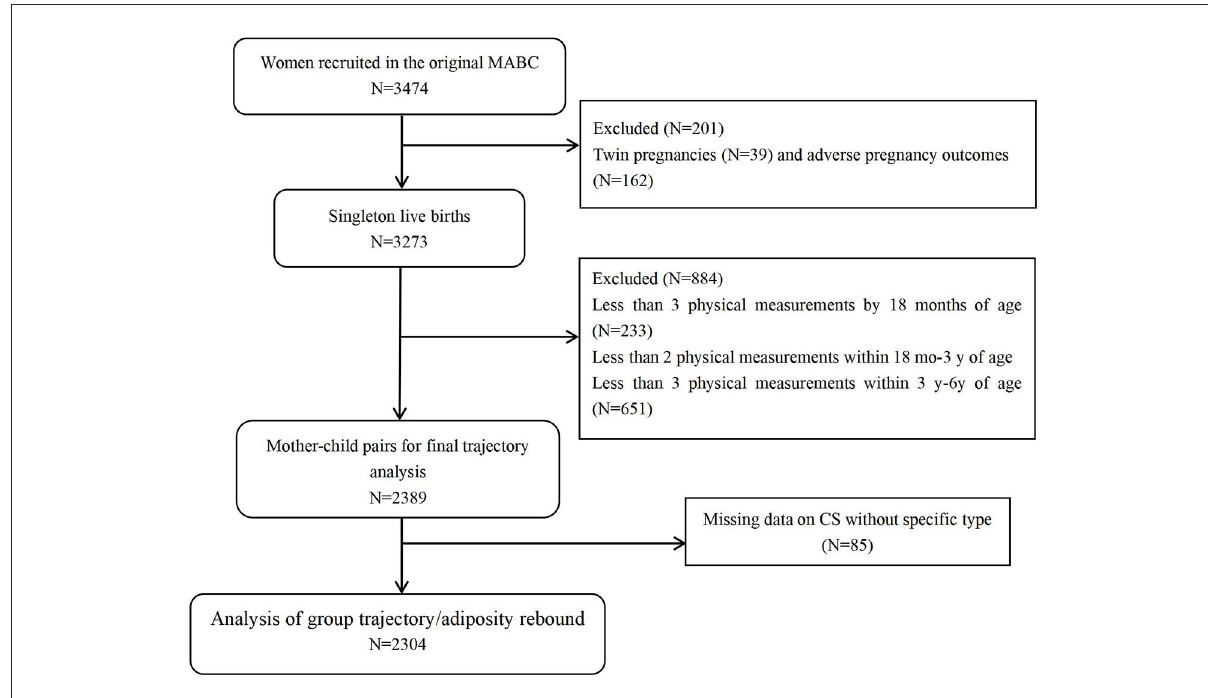
FIGURE1 Flowchart of study